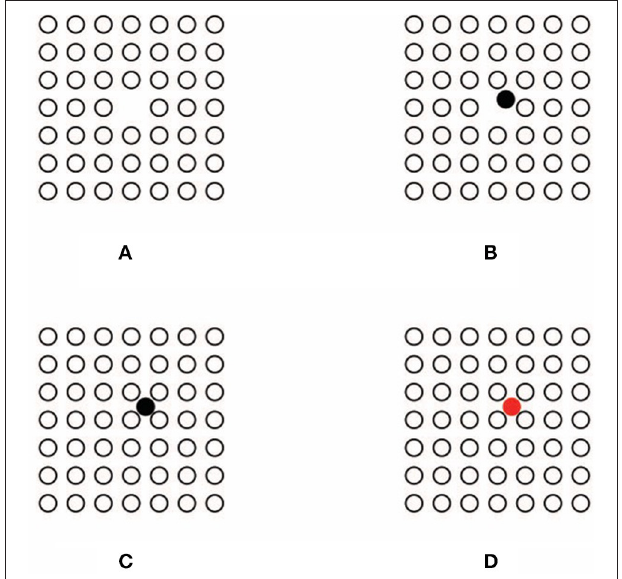
FIGURE 4 | The perception of an absence (A), of a wrong spatial position (B), of an intruder